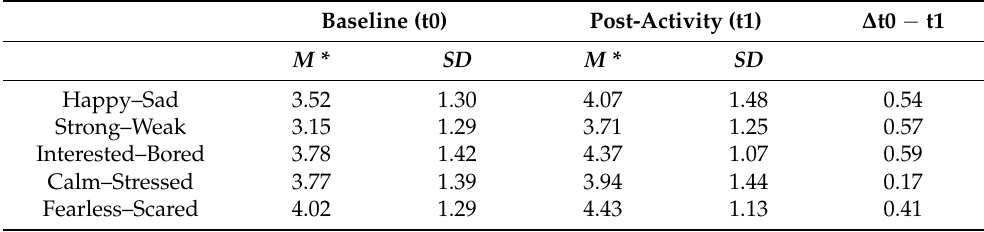
Table 1. Descriptive statistics for emotional states (B1) at baseline (t0) and post-activity (t1) for the entire sample ( N = 61).